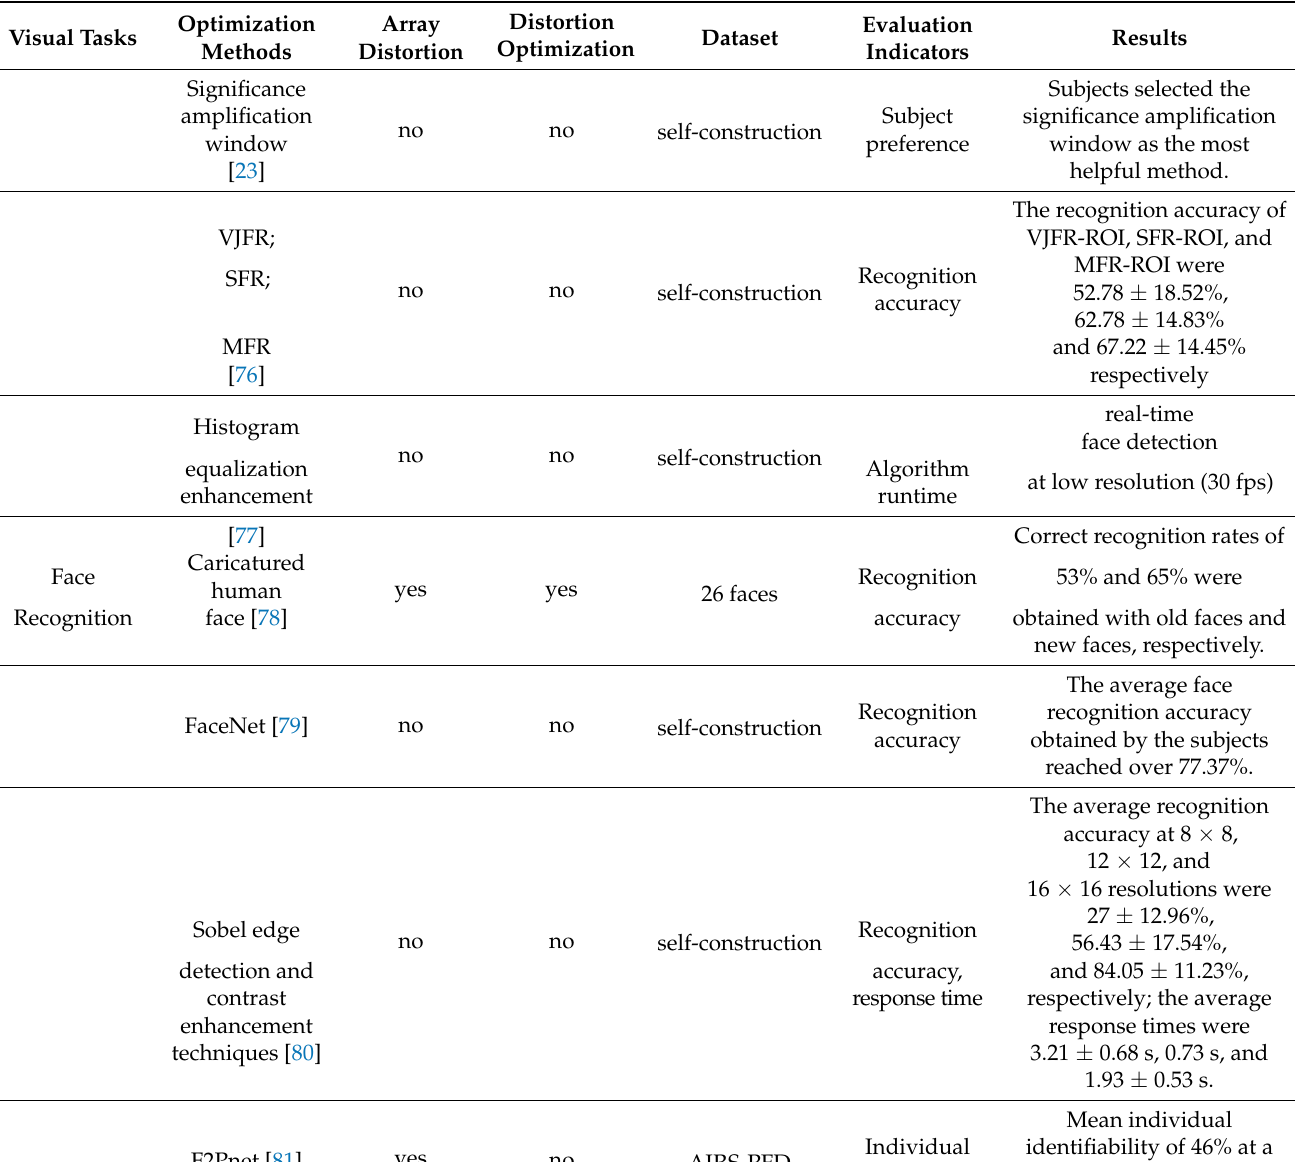
Table 2. Image processing optimization on visual